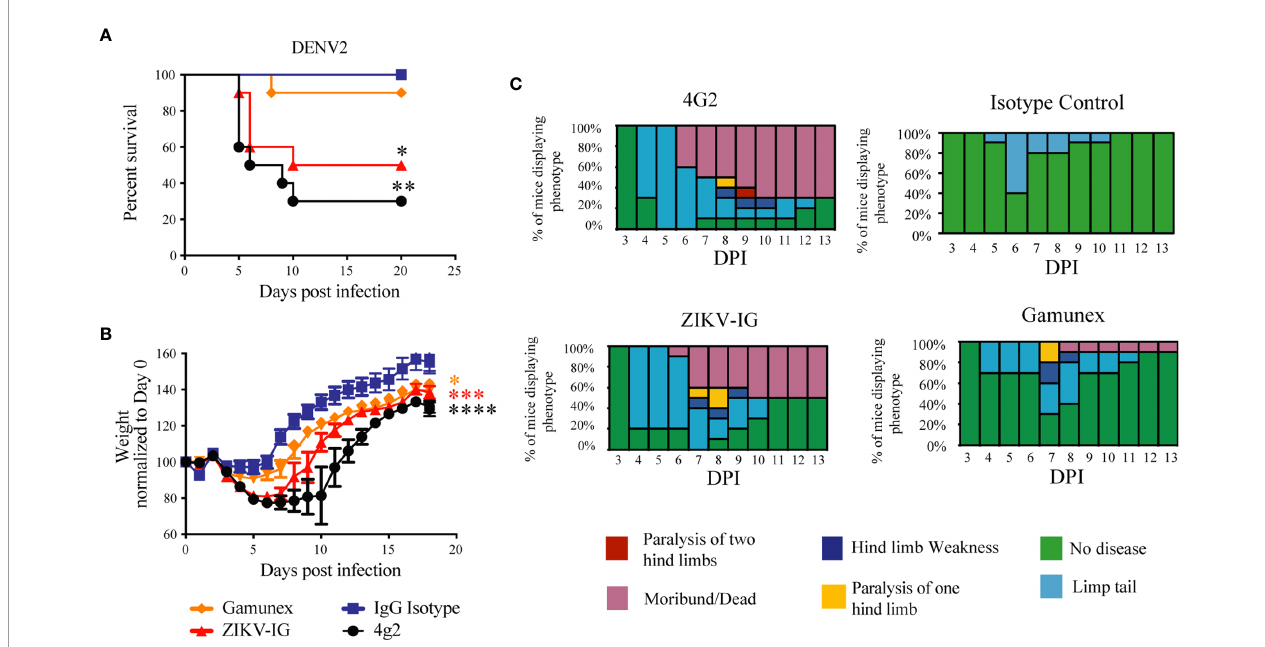
FIGURE 6 | Weight loss, Survival and clinical score of DENV2 -infected Ifnar mice under ADE conditions. Ifnar -/- mice were transferred passively isotype control (0.020 mg of mouse anti-NP or 2 mg of Gamunex ® ) or enhancing mAbs (0.020 mg of anti-E (4G2) or 0.050 mg of ZIKV-IG) and then infected a day later with 10 4 FFU of DENV-2 (strain D2S20) via an intravenous route. Survival (A) weight change (B) and clinical score (C) were monitored, and the data re fl ects 10 mice per group. Treatment with either ZIKV-IG or 4G2 increased the susceptibility of mice to severe DENV2 disease, signi fi cance in comparison to the isotype control mAb is provided in black (*) and signi fi cance in comparison to Gamunex ® is provided in red (*). Mice were evaluated for signs of disease daily and graphed on each day as a percentage of mice displaying that disease indicator. Signs of disease range from no apparent disease, limp tail, hind limb weakness, hind limb paralysis, complete paralysis to death. Mortality curve was analyzed by Log-rank test, Body weight comparison on single days was completed by Dunnett ’ s test, comparisons of weight over time was completed by 2-way ANOVA, while number of disease days was determined by Fisher exact test. Statistical differences are denoted by a star *p < 0.05, **p < 0.005, ***p < 0.0005, ****p <